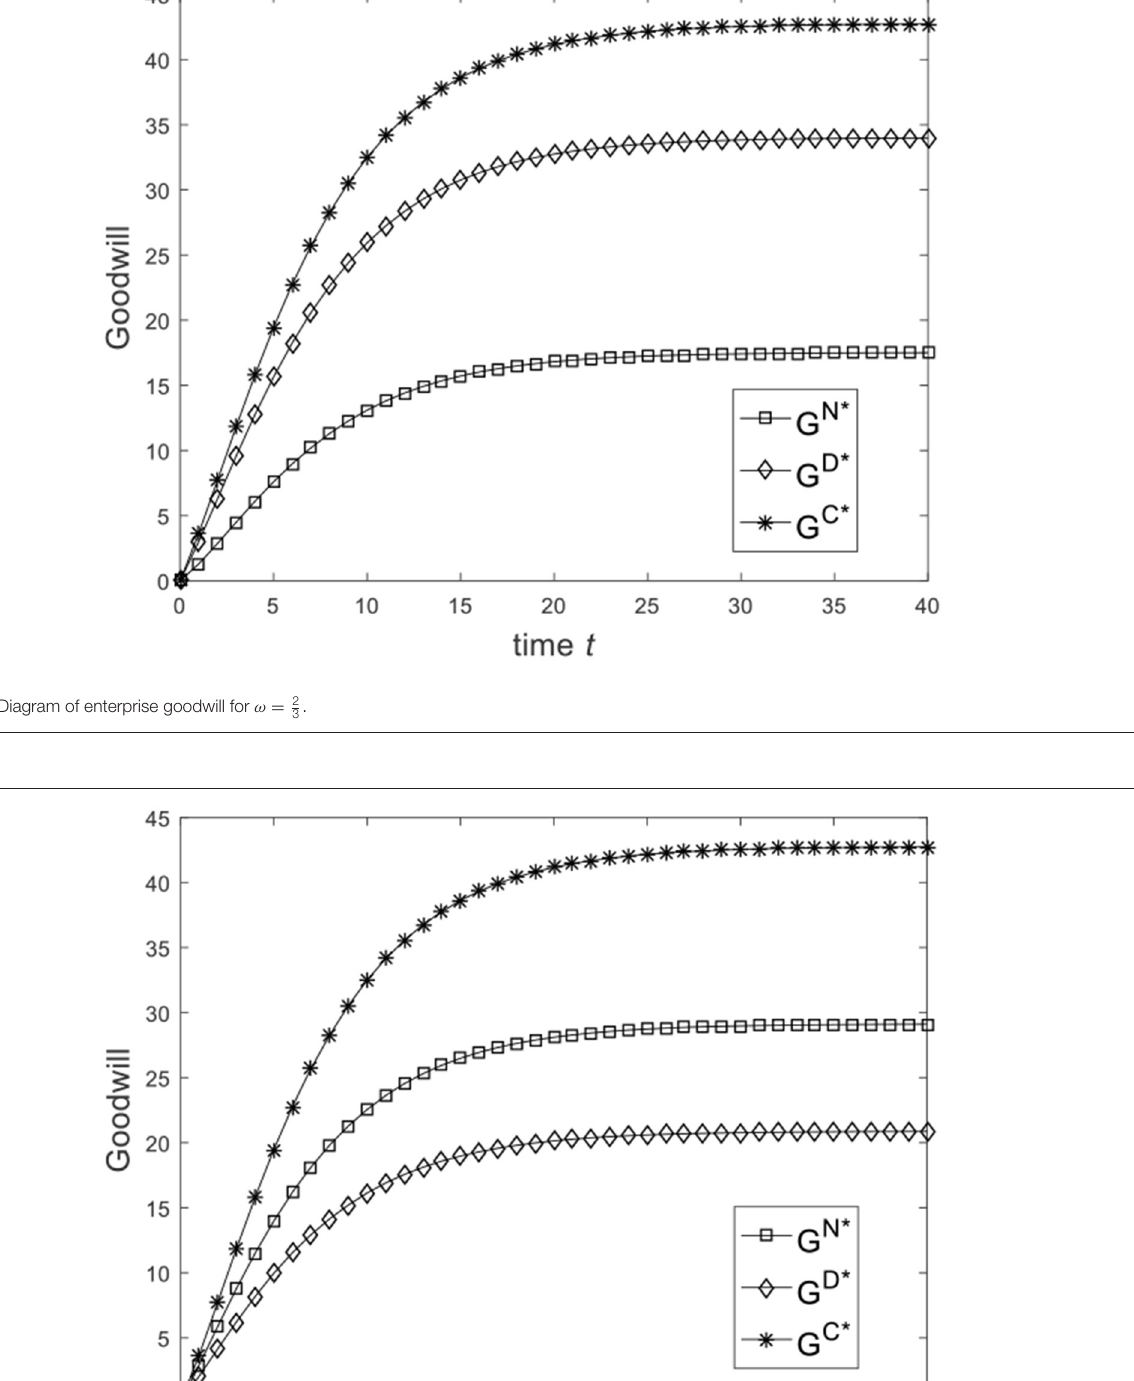
FIGURE 4 | Diagram of enterprise goodwill for ω